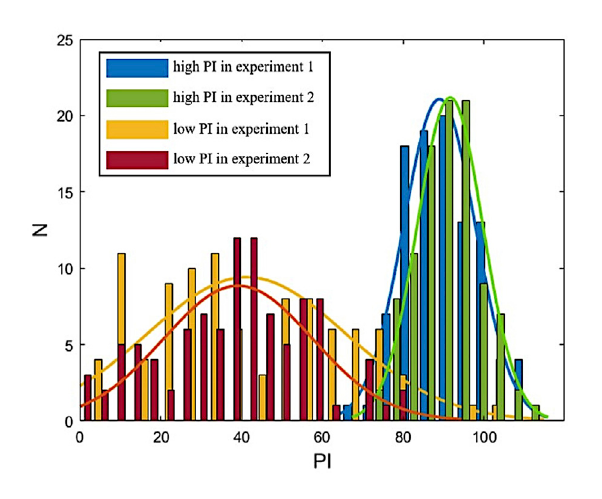
FIGURE 3 Distribution of the PI in experiments.